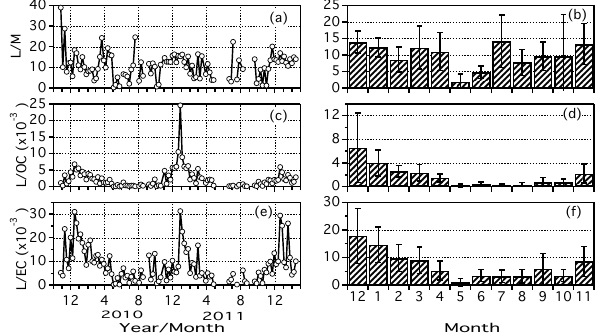
Figure 6. Temporal variations (a, c, e) and monthly means (b, d, f) of the ratios of levoglucosan to mannosan (L / M), OC (L / OC) and EC (L / EC) in aerosols at Cape Hedo, Okinawa, from October 2009 to February